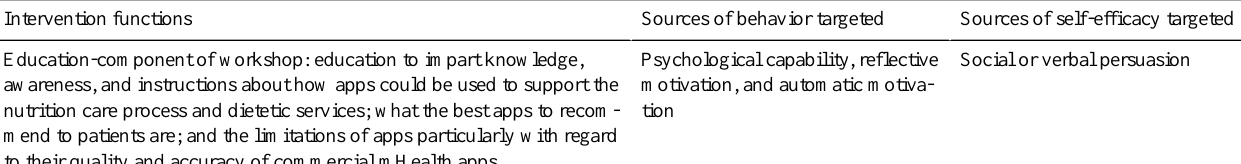
Table 1. Intervention functions included in the education and training workshop and 12-week intervention phase that targeted deficits in the sources of behavior (capability, opportunity, and motivation) as classified by the Capability, Opportunity, Motivation-Behavior (COM-B) model, and the sources of self-efficacy, according to Bandura.